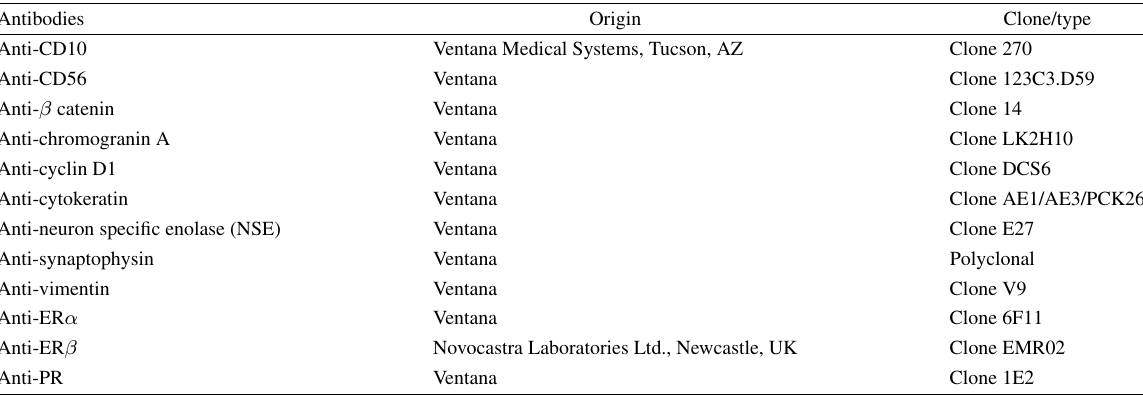
Antibody sources for immunohistochemical and cytochemical tests